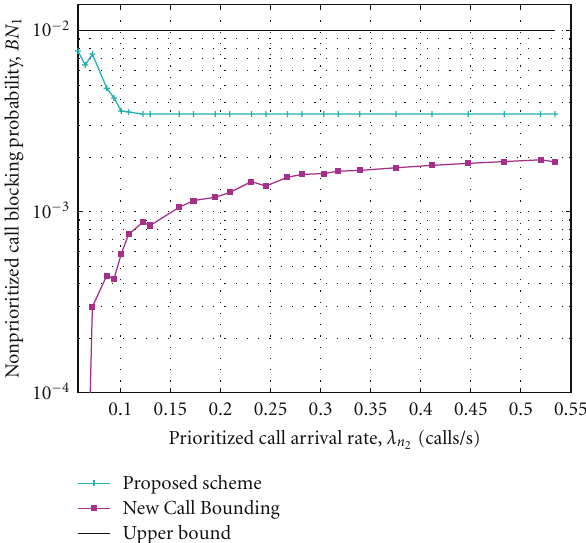
Figure 3: Prioritized call dropping probability versus prioritized calls arrival rate.